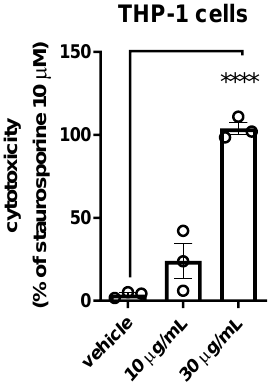
Figure 2. Cytotoxic properties on THP-1 cells. The data are presented as mean ± SEM from n = 3 independent experiments. Data were analyzed for differences by one-way analysis of variance (ANOVA). Significance level is given as **** p < 0.0001.